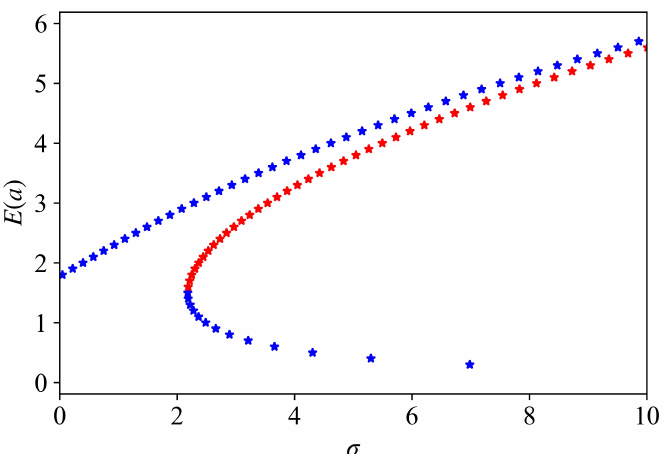
Figure 2. The variations in the mean amplitude E ( a ) with the detuning frequency σ . The blue star corresponds to the steady solutions and the red star corresponds to the non-steady